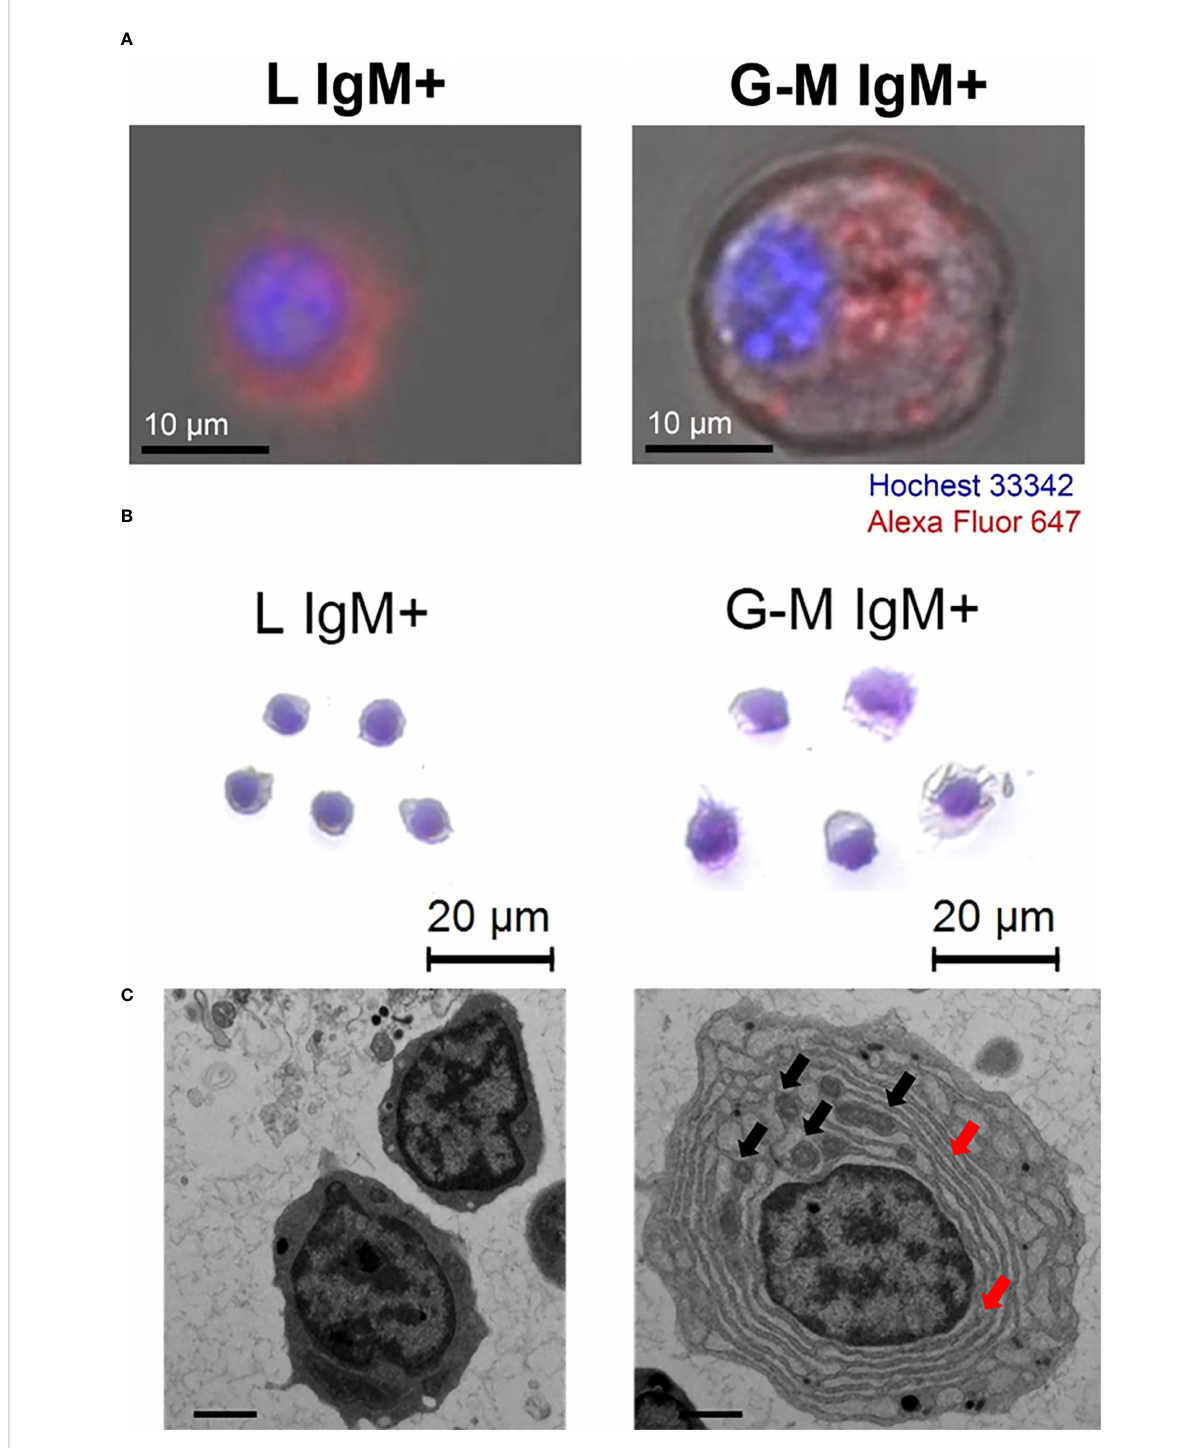
FIGURE 2 Morphological characterization and ultrastructural features of tilapia IgM + cells from L and G-M gates. L-gate and G-M gate IgM + cells were sorted from anterior kidney (AK) leukocytes and stained with 647-labeled mouse anti-IgM mAb using fl ow cytometry, as shown in Figure S1, and were visualized and observed with (A) a Zeiss LSM 710 confocal microscope, (B) hematoxylin and eosin staining, and (C) transmission electron microscopy. For ultrastructural analysis, the representative cells were magni fi ed 6000-fold and the scale bar represents 1 m m. Black arrowheads indicate mitochondria and red arrowheads indicate endoplasmic